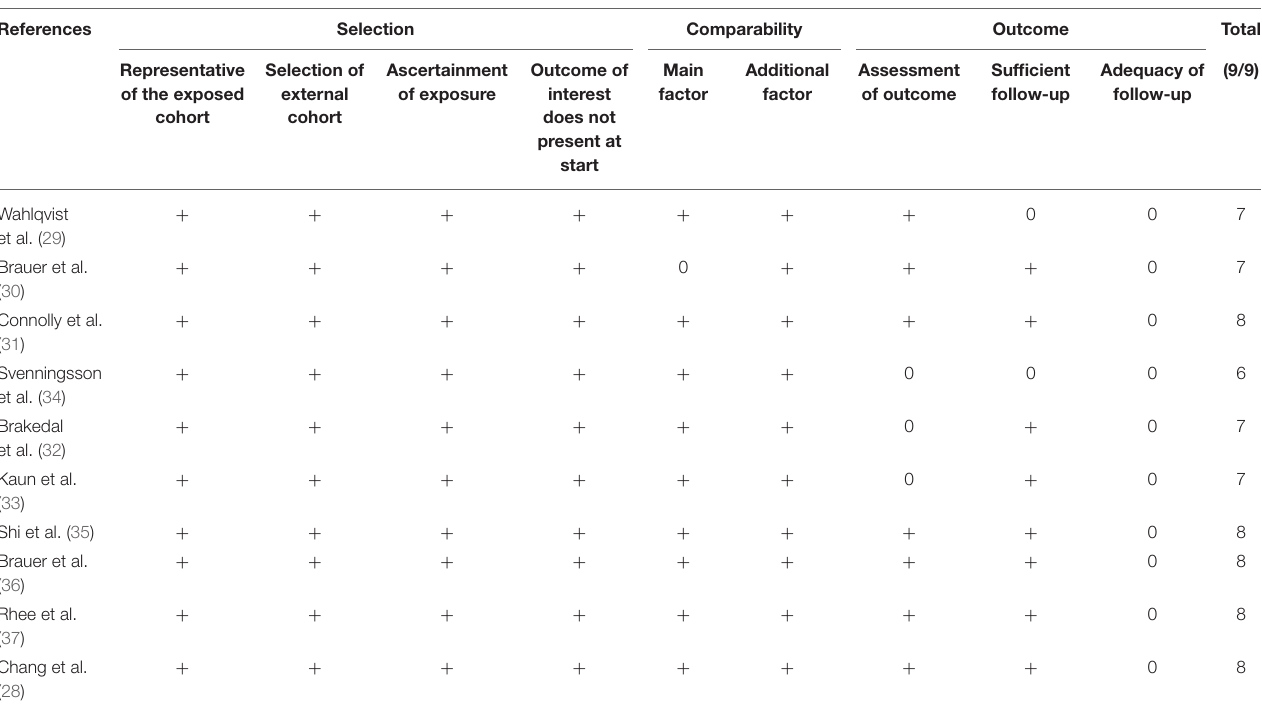
TABLE 2 | Risk of bias evaluation of individual